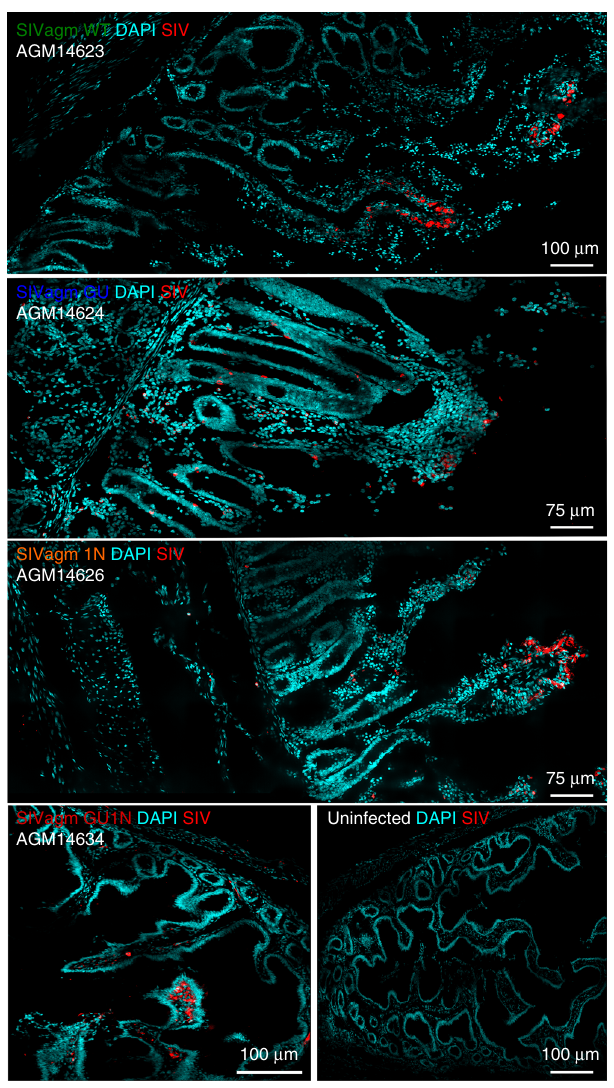
Fig. 7 SIV distribution in AGM jejunum sections during the chronic phase of infection. Confocal images of SIV-infected cells (red), nucleus (blue) in Jejunum for each group are shown. Representative SIV-speci fi c in situ hybridization during chronic infection, demonstrating productively infected cells in jejunum for each virus. Jejunum sections from an uninfected monkey were used as control to demonstrate the speci fi city of the SIV probes. Images derived from mounted multiple confocal projected z -scans. Pictures were obtained using a Leica SP8 confocal microscope and processed with ImageJ